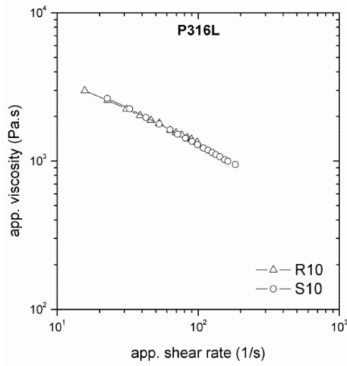
Figure 5. Effect of surface roughness on flow properties of P316L, stainless-steel powder 316L, in the partly water-soluble binder system PolyMIM